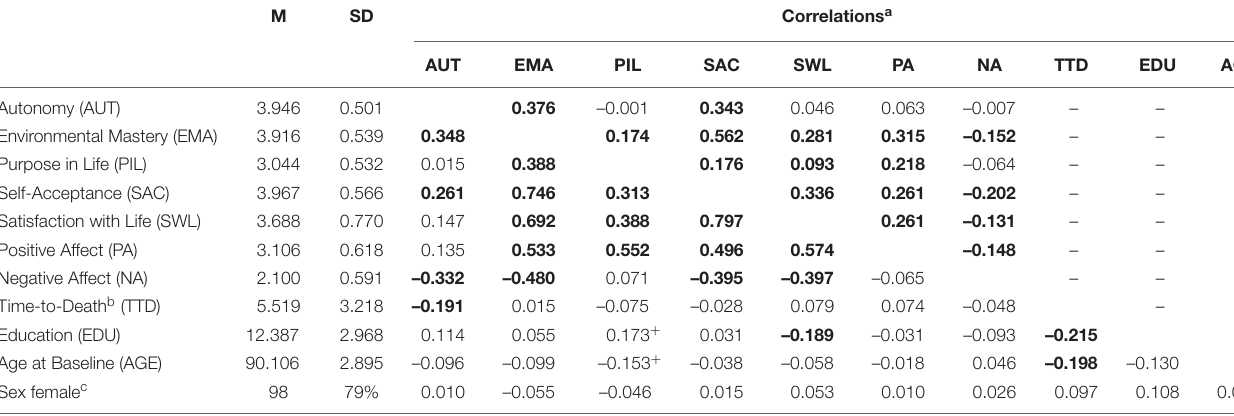
a Between-person correlations below diagonal, within-person correlations above diagonal, correlations in bold print significant with p < 0.05, + p < 0.10. b Time-to-death at baseline right centered, including 2 study survivors. c Number and percentage of female participants in M and SD (standard deviation) columns,